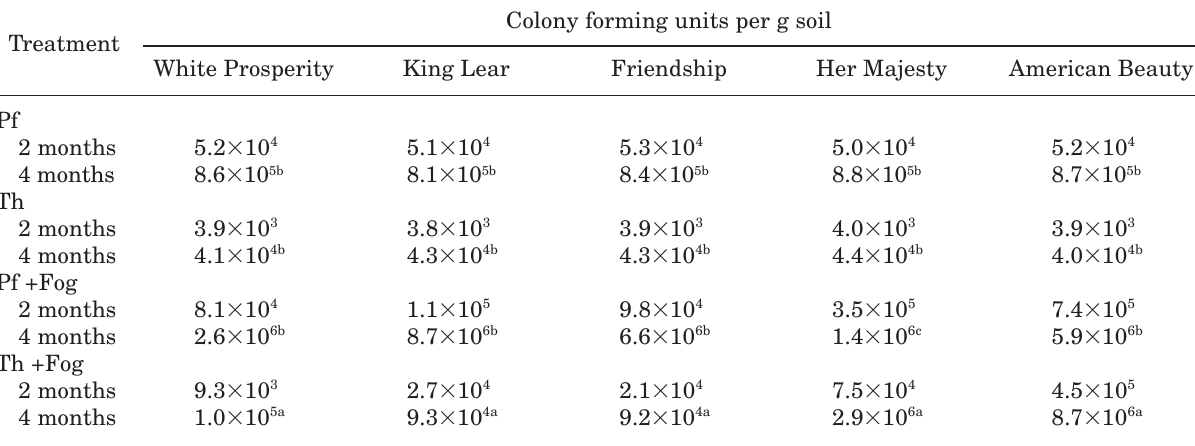
Table 5. Populations of Pseudomonas fluorescens (Pf) and Trichoderma harzianum (Th) in the rhizosphere of gladi- olus cultivars grown in the soil with or without Fusarium oxysporum f. sp. gladioli